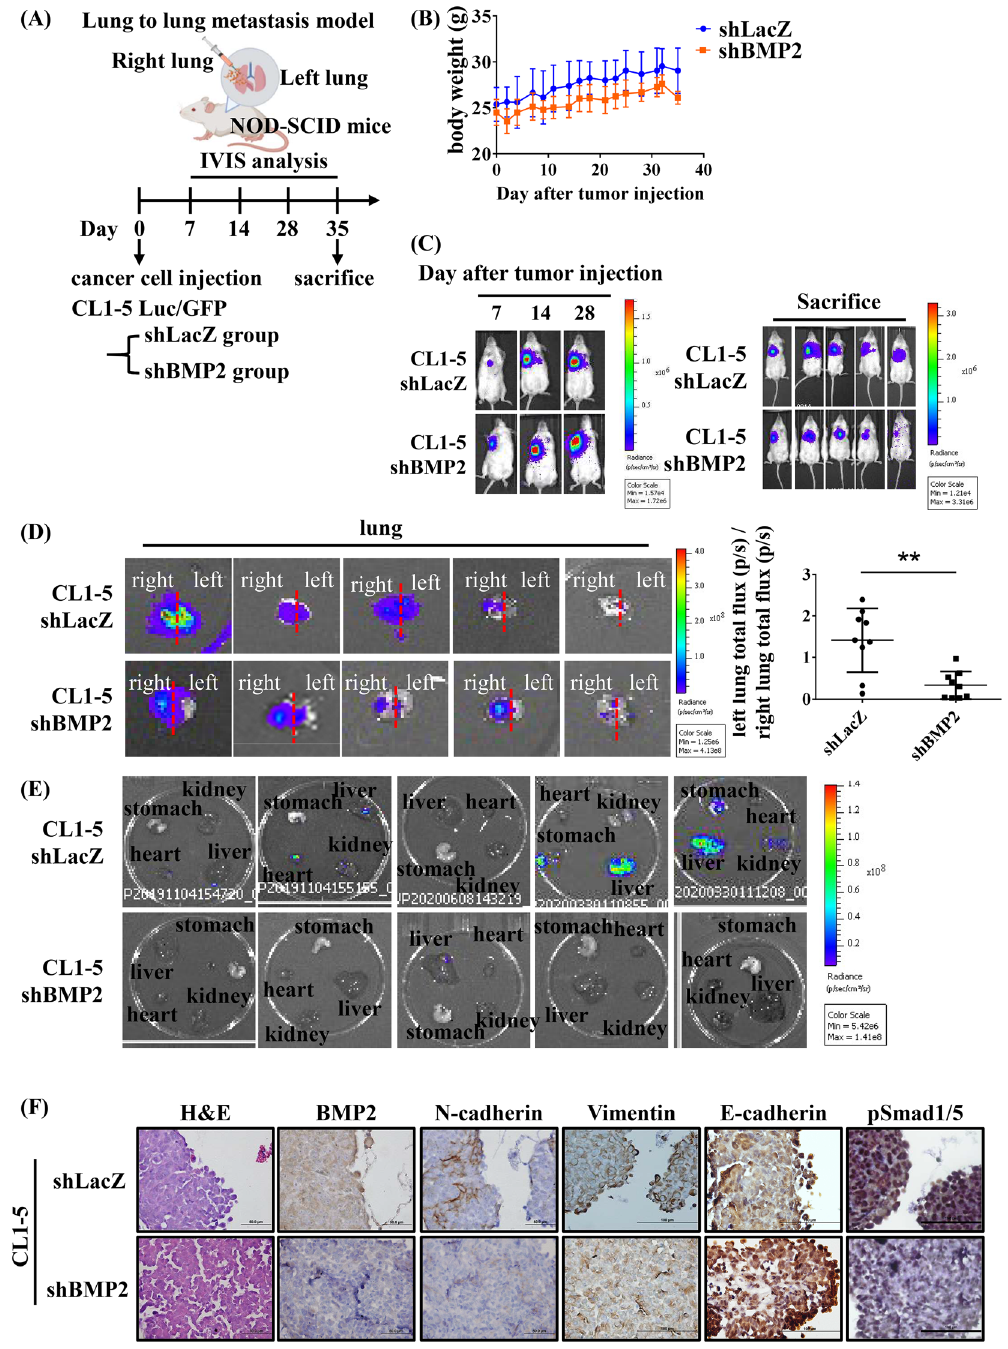
Figure 6. Inhibition of BMP2 decreased metastasis in a CL1-5 orthotopic mouse model. ( A ) A schematic diagram showing the animal experiment. CL1-5 cells stably expressing shLacZ or shBMP2 Luc/GFP were injected into the right lungs of NOD-SCID mice. IVIS analysis was conducted at 7, 14, 28, and 35 days after injection. ( B ) The body weights of mice were measured three times per week after tumor injection. ( C ) Metastasis in shLacZ and shBMP2-CL1-5-Luc/GFP groups was measured by IVIS until sacrifice. ( D , E ) Metastastic lesions in the lungs ( D ) and nearby organs ( E ) were analyzed by IVIS after sacrifice. ( F ) Hematoxylin and eosin (H&E) and IHC stains in mouse right lung tissue for the indicated proteins. Slides were observed under 40 × magnification. Error bars represent SD, and p -value was determined by Student’s t test (* p < 0.05, ** p < 0.01, *** p <